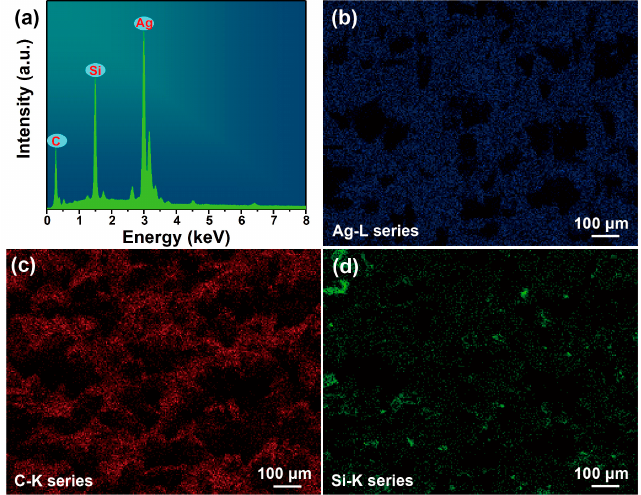
Figure 7. ( a ) EDS of Ag-coated sandpaper and the corresponding local elemental mapping of ( b ) Ag; ( c ) C; and ( d ) Si.